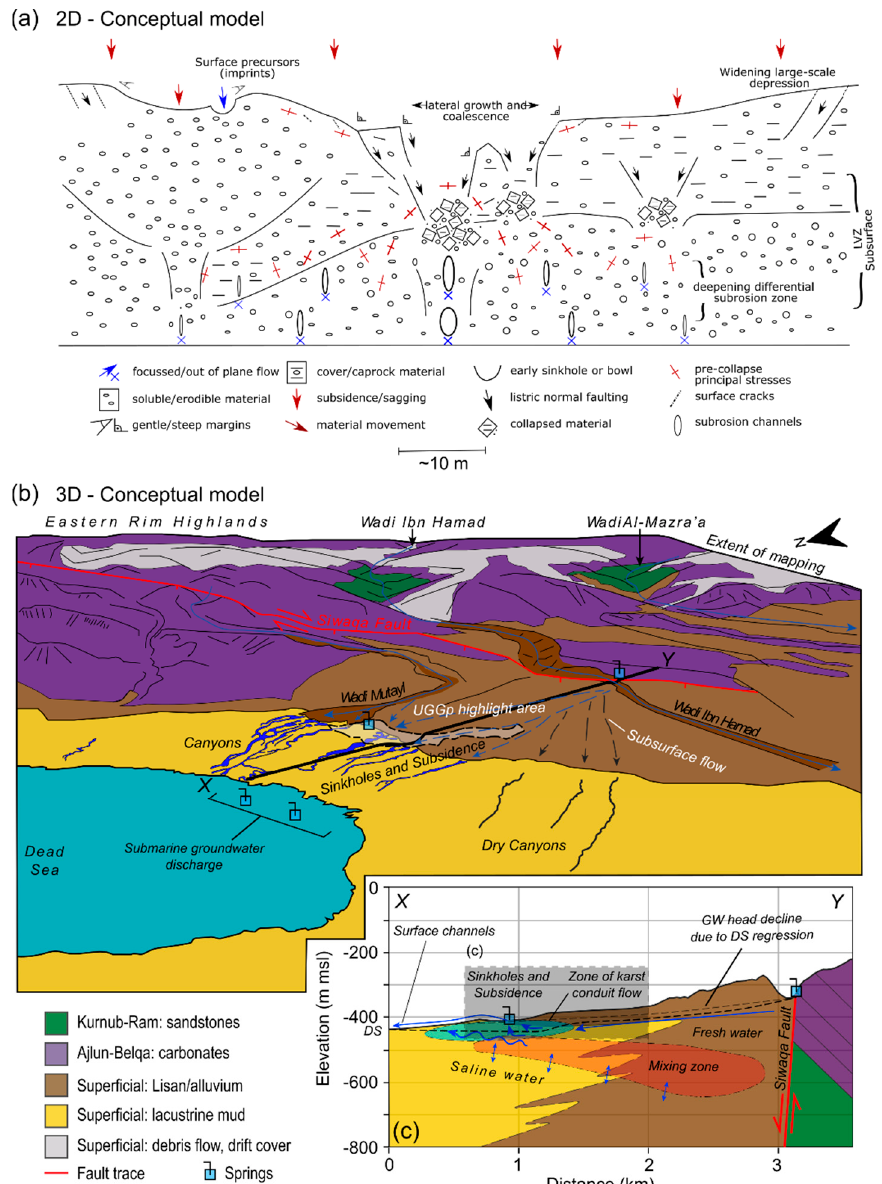
Figure 3. Conceptual overview of geology, hydrogeology, and geomorphology at the highlight area Ghor Al-Haditha sinkhole site. ( a ) is a 2D conceptual model of karst and related morphological expressions for the area, modified after [47]. ( b ) is a 3D conceptual model based on an interpreted geological map of the Ghor Al-Haditha sinkhole area, which could serve as an interpretation panel for the visitors in a lighter form. ( c ) is the cross-section X–Y with additional hydrogeologic information. Both ( b,c ) are modified after [26].